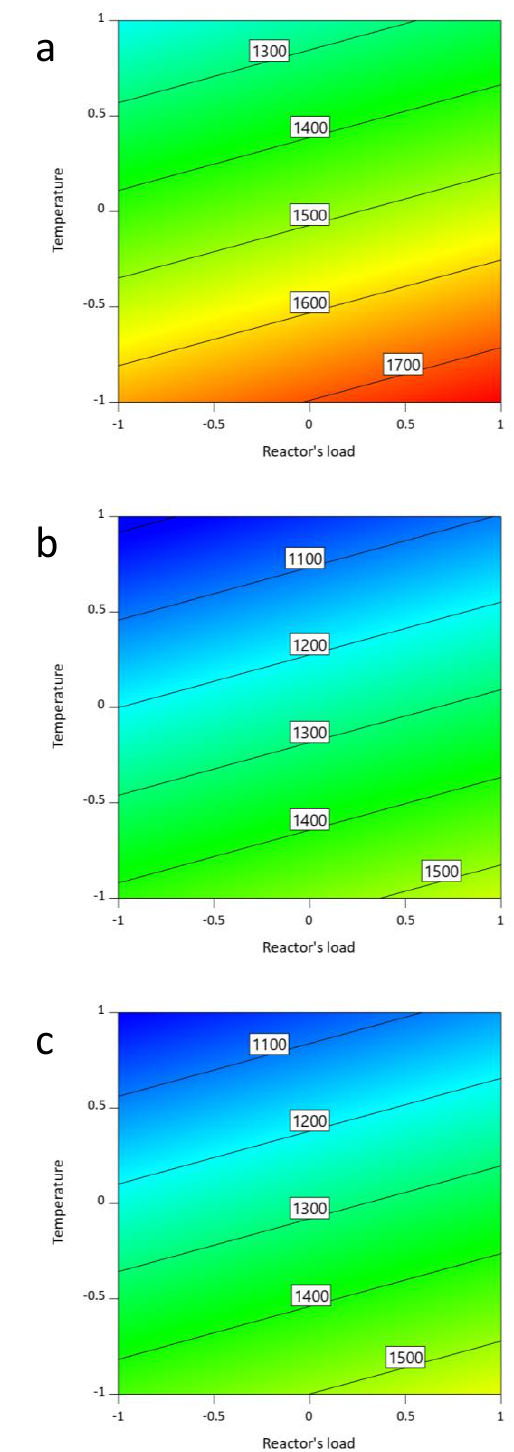
Figure 5. Interaction effect between the reactor’s load ( X 1 ) and the temperature ( X 2 ) at fixed number of catalytic gauzes ( X 3 ) on N 2 O concentration in nitrous gases ( R 2 ) by contour plot. ( a ) X 3 = − 1; ( b ) X 3 = 0; ( c ) X 3 = 1.